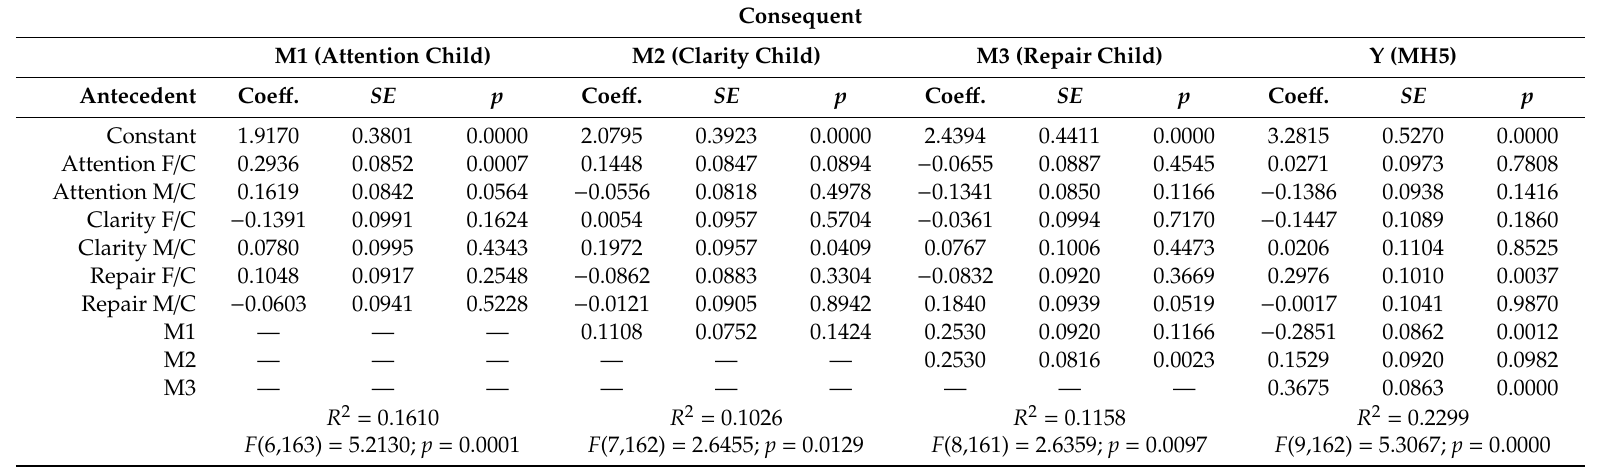
Table 2. Regression coe ffi cients, standard errors, and model summary information for the serial multiple mediator model with EI perceived by parents about children as explanatory variables (model related to